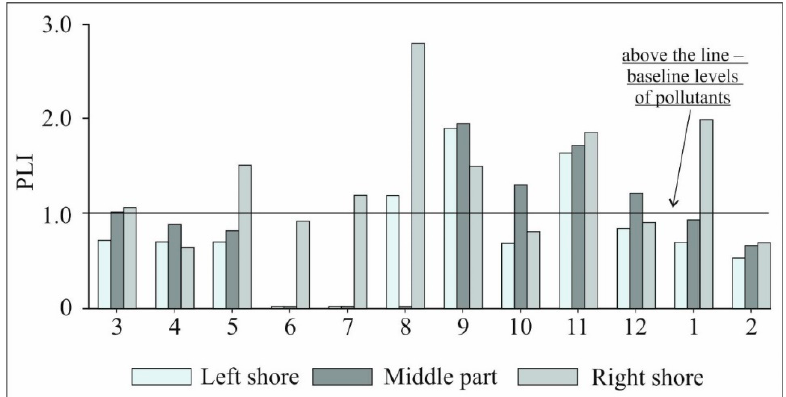
Figure 6. Pollution load index ( PLI ) in water of Angara River source (3—March 2021, 4—April, 5—